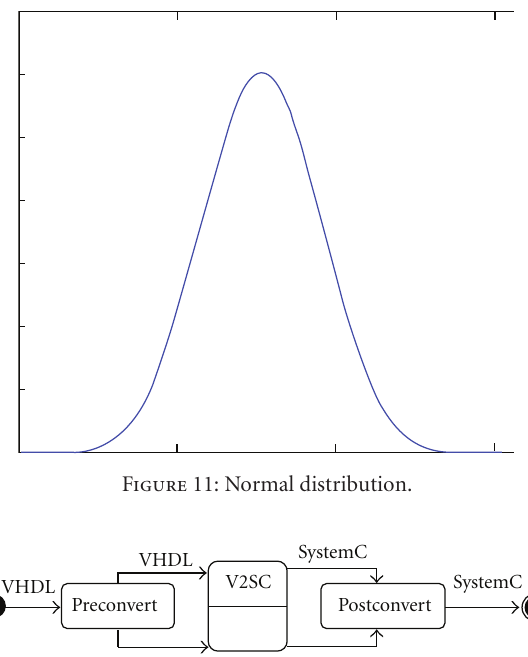
Figure 12: Combination of wrapper and V2SC.